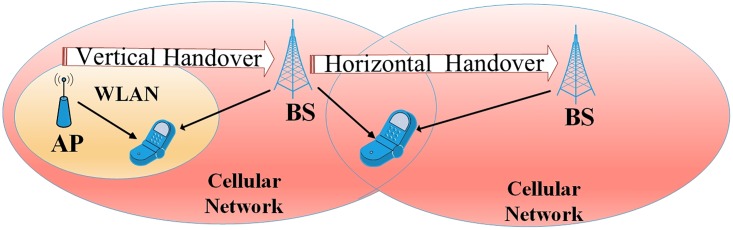
Handover types [37].